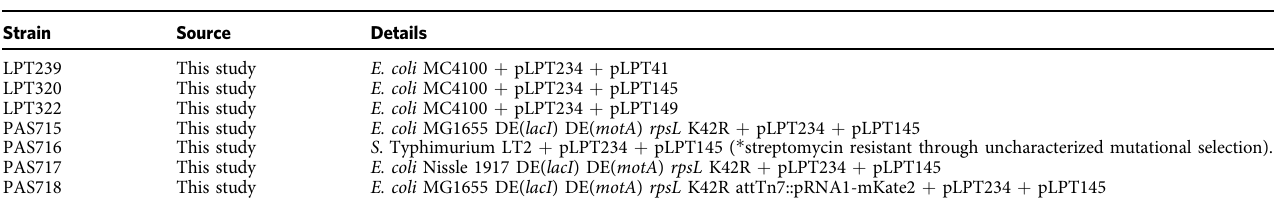
Supplementary Table 1: Strains used in this